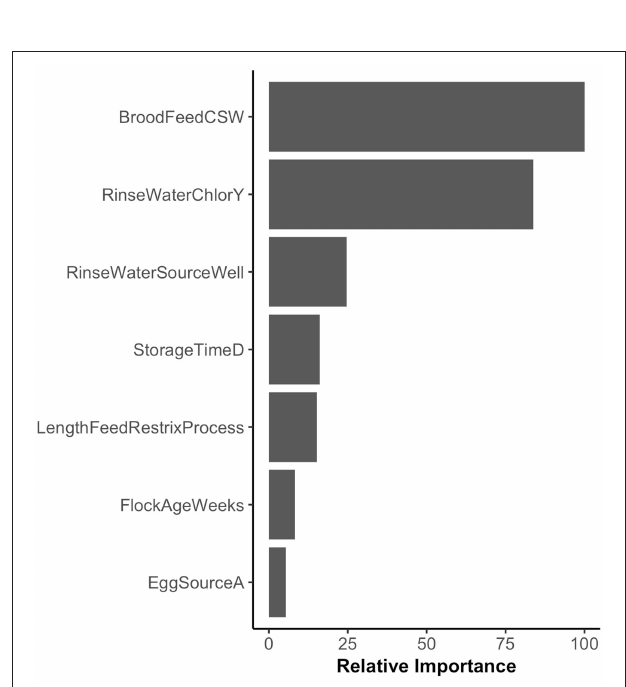
FIGURE 3 | Variable importance plot for the whole carcass rinse (WCR) final product random forest model. Relative importance is determined by average mean decrease in Gini and scaled from 0 to 100, where 100 is most important. BroodFeedCSW refers to brood feed with top 3 sources of protein as corn, soy, and wheat. RinseWaterChlorY refers to farms that chlorinated rinse water used during broiler processing. RinseWaterSourceWell refers to farms